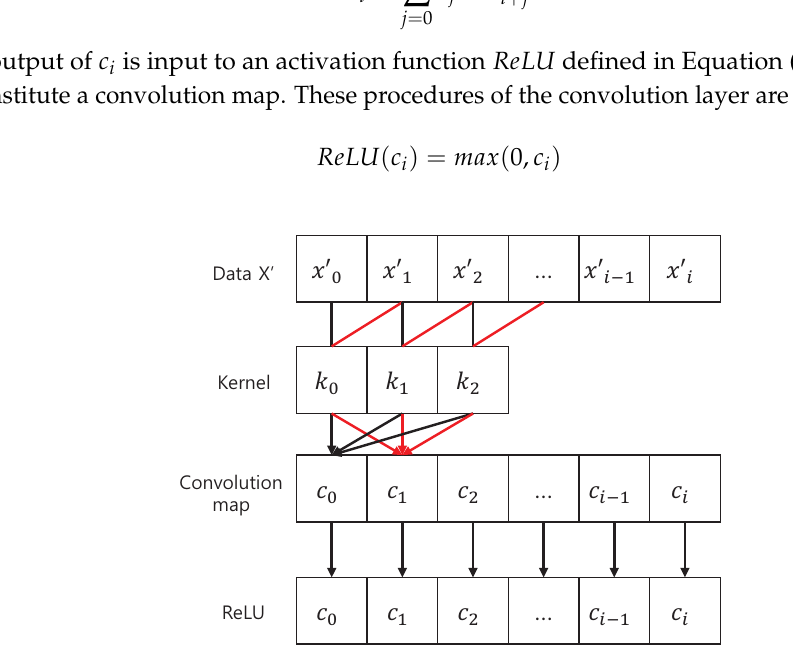
Figure 5. Operation of the one-dimensional convolution